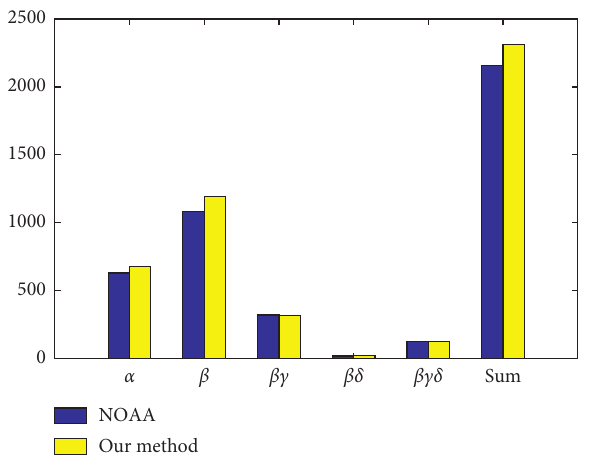
Figure 9: The numbers of various types of sunspot groups detected by our method and NOAA in Here, it is judged by our method to be β c . Now, in the second but with more than one continuous polarity reversal line. row that follows, it is judged as δ because of the umbra with What level is simple or complex especially in the transitional opposite polarity appear in the same penumbra, which are period from one type into another type during its evolution?